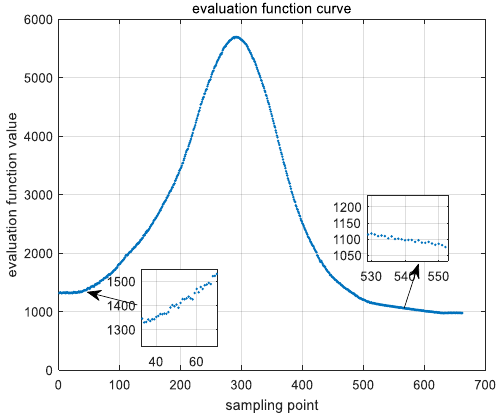
Figure 10. Evaluation function